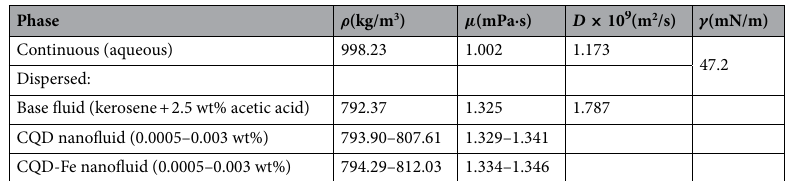
Table 1. The physical properties of the continuous and dispersed phases of the chemical system at 20 °C.